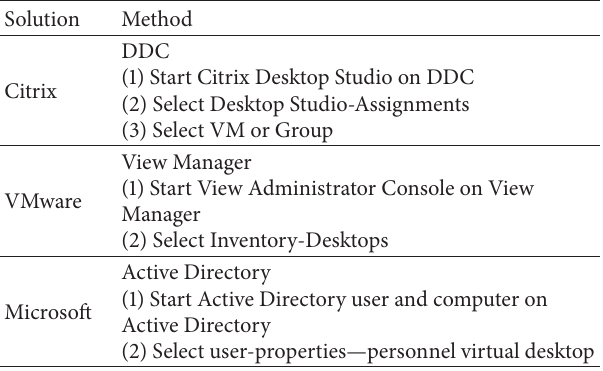
Table 6: Method for finding assignment information in the connec- tion management